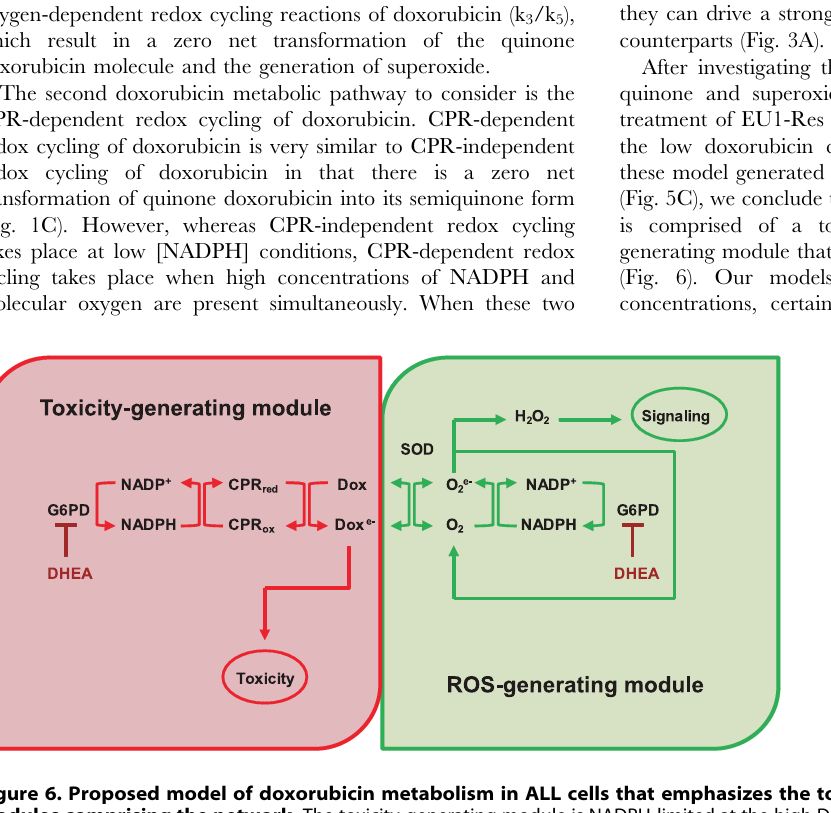
Figure 6. Proposed model of doxorubicin metabolism in ALL cells that emphasizes the toxicity-generating and signal-generating modules comprising the network. The toxicity-generating module is NADPH-limited at the high Dox condition, allowing DHEA administration to decrease NADPH-dependent semiquinone doxorubicin formation. The signal-generating module is NADPH-limited at the low Dox condition, allowing DHEA administration to decrease NADPH-dependent superoxide